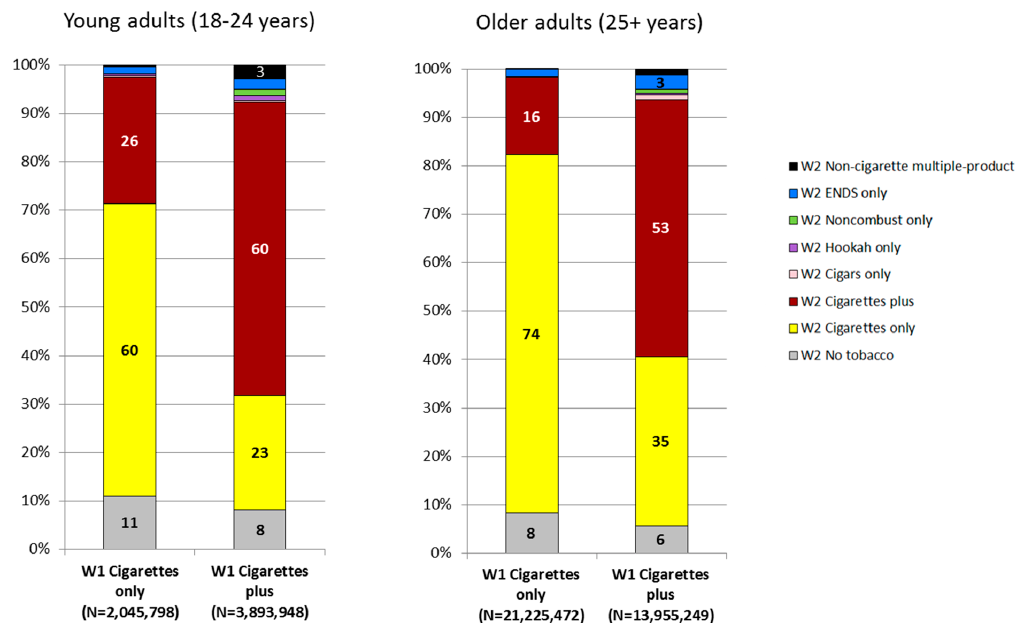
Figure 2. Transitions in current cigarette use among young adults (aged 18–24 years) and older adults (aged 25+ years) in the United States: 2013–2014 to 2014–2015. Notes. Each bar in the figure represents a cigarette user group at Wave 1 (W1). N underneath each bar indicates the weighted population size for each cigarette user group at W1 (i.e., the scale of the y-axis differs across bars). Transitions between W1 and Wave 2 (W2) are indicated by the colored distribution of each bar; for